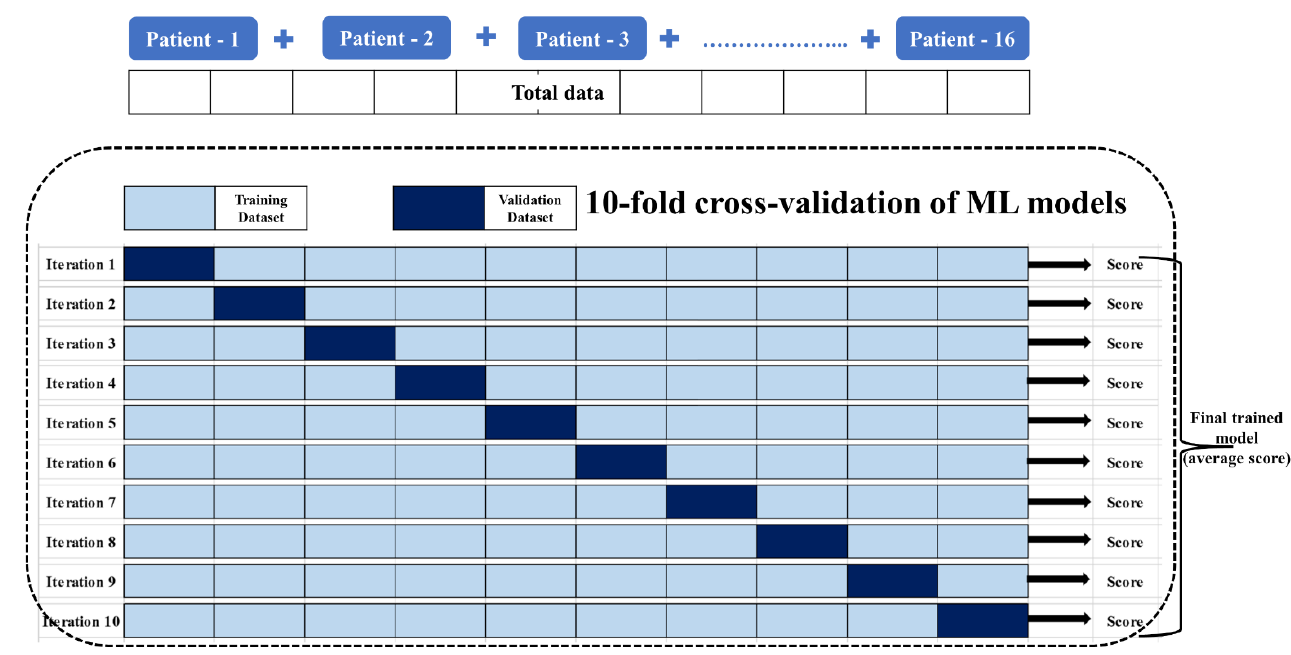
Figure 4. 𝒌 − fold cross-validation of ML model, where 𝒌 = 𝟏𝟎 . Figure 4. k —fold cross-validation of ML model, where k = 10 .